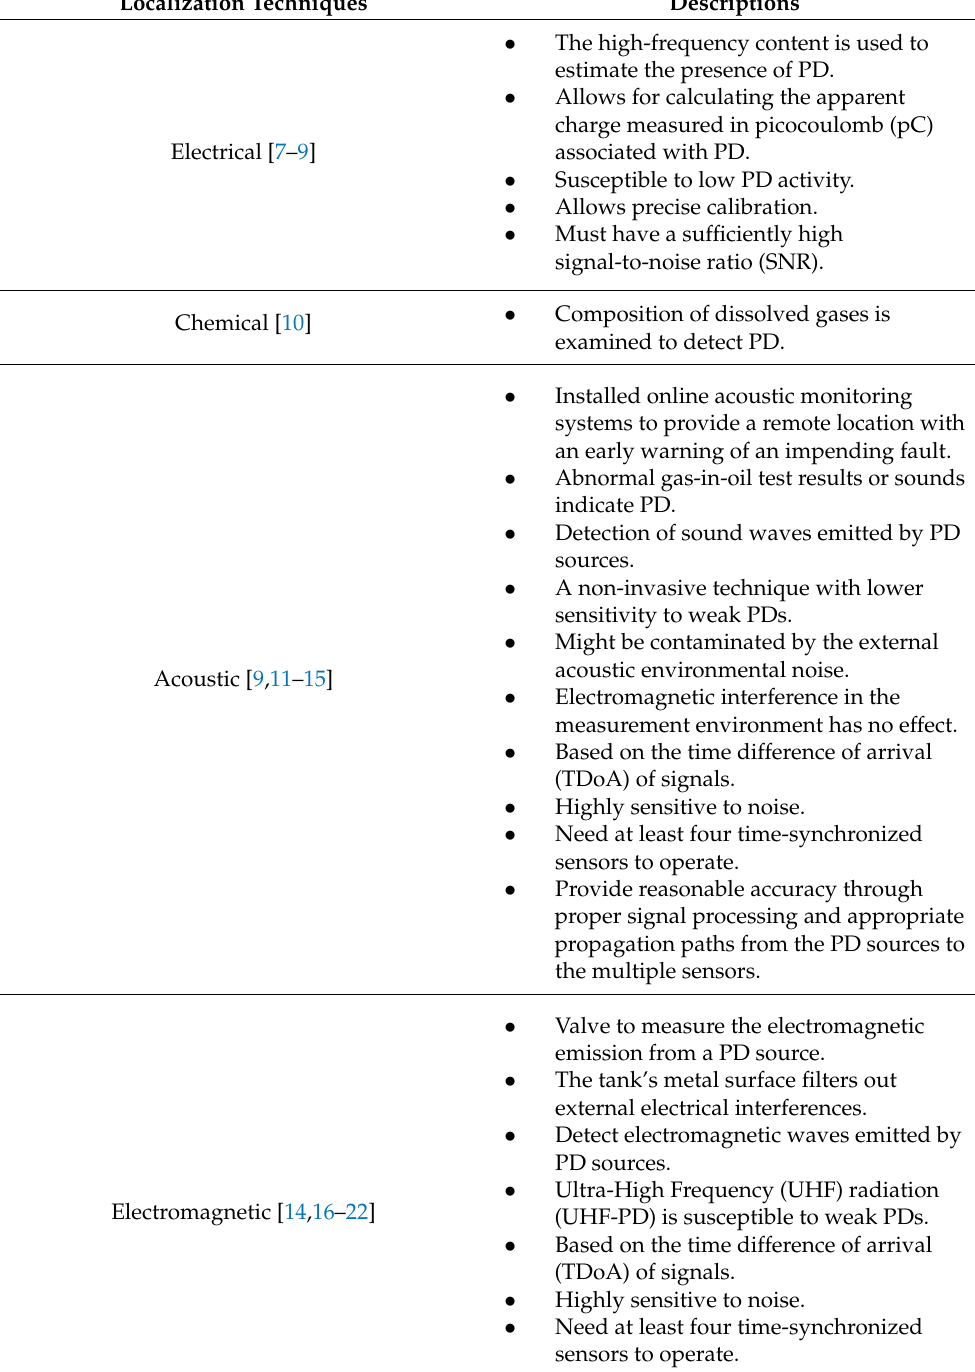
Table 1. PD detection and localization techniques. Localization